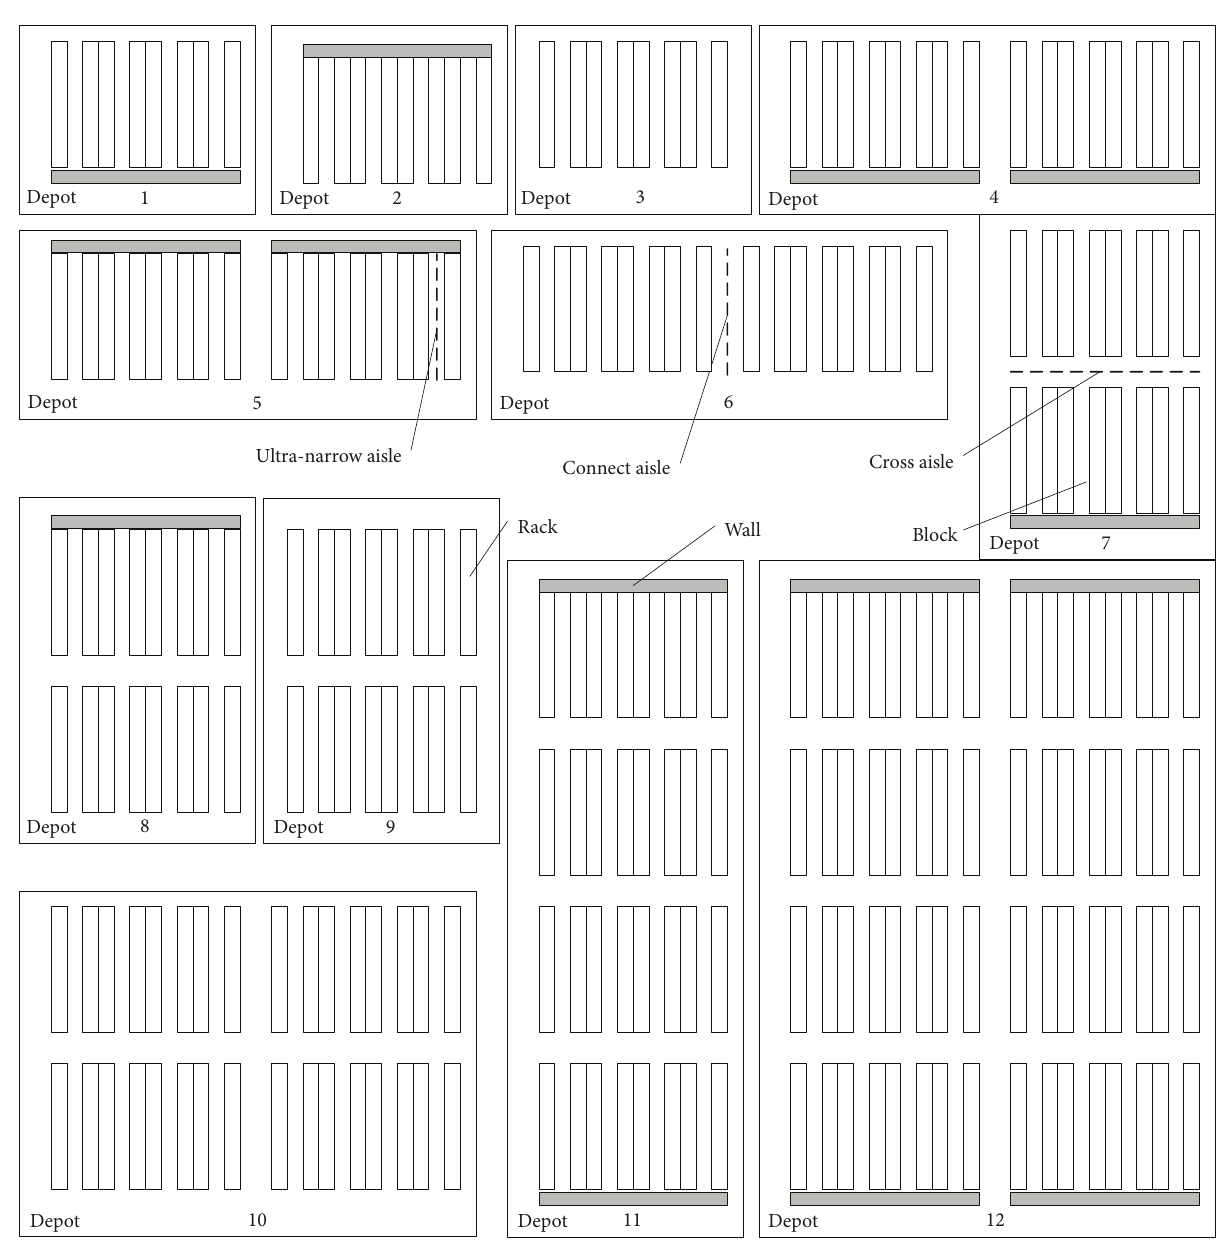
Figure 10: Warehouse scenarios concerned in the